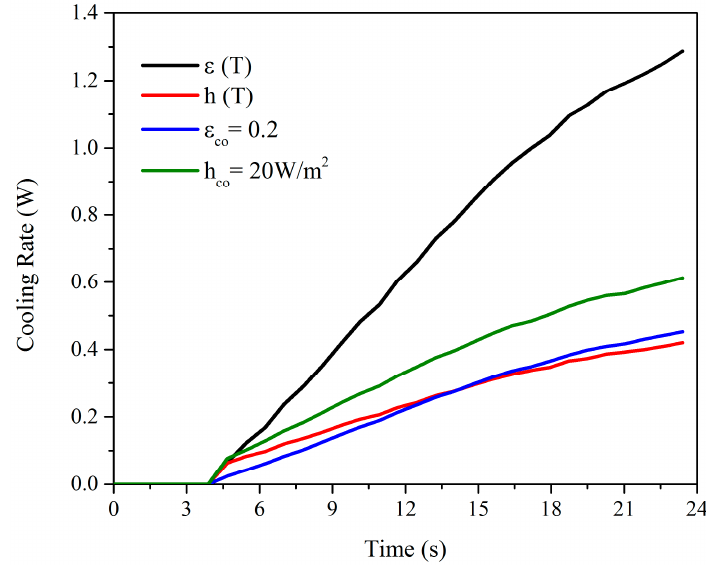
Figure 9. Heat losses in the fusion zone for t+ = 2 ms.